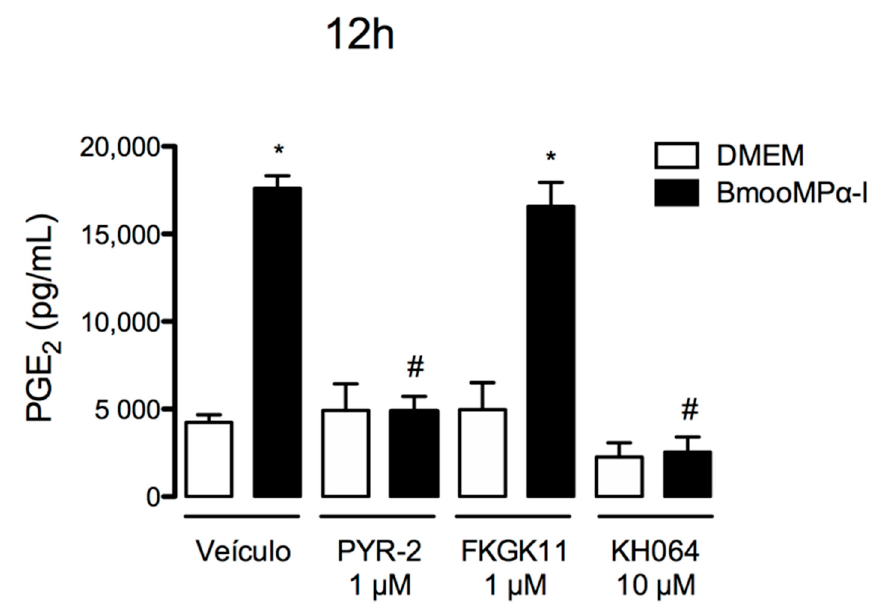
Figure 4. BmooMP α -I-induced release of PGE 2 and COX-2 expression are dependent on metalloproteinase enzymatic activity. Cultured preadipocytes were incubated with BmooMP α -I (0.24 μ M) (Bmoo), Batimastat (Bat), BmooMP α -I + Batimastat, or vehicle (DMSO) for 6 h: ( A ) concentration of PGE 2 present in culture supernatant was quantified by ELISA; ( B ) representative Western blotting of COX-2 and β -actin (loading control) showing immunoreactive bands; ( C ) densitometric analysis of immunoreactive COX-2 bands. Densities (in arbitrary units) were normalized to β -actin densities. Results are expressed as means ± SEM of 4 samples. Note: * p < 0.05 relative to control; # p < 0.05 relative to BmooMP α -I (with vehicle) (one-way ANOVA, Bonferroni post-test).